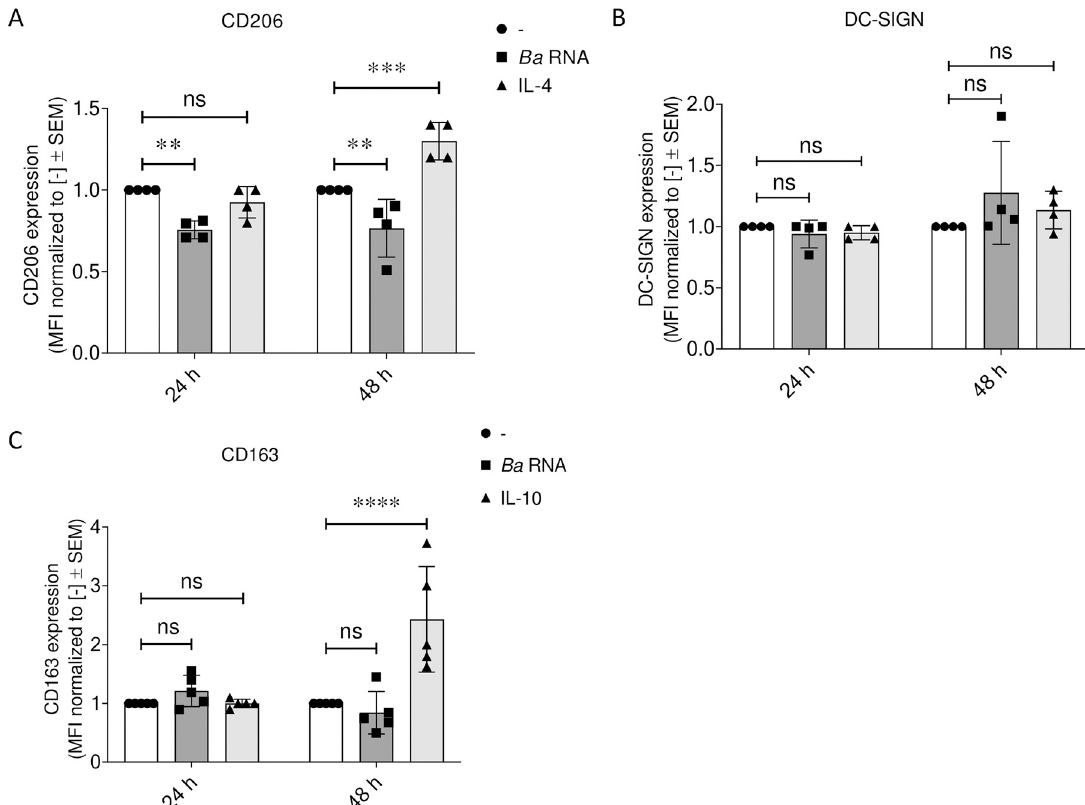
Fig 3. Ba RNA does not modulate the expression of M2 markers. Human M0 macrophages were stimulated with Ba RNA for 24 and 48 h. (A) CD206, (B) DC-SIGN and (C) CD163 (M2 markers) expressions were determined by flow cytometry. Cells treated with IL-10 or IL-4 were used as controls. Bars indicate the geometric means normalized to untreated cells ± SEM of at least four independent experiments. MFI, mean fluorescence intensity. ns, non-significant; �� P < 0.01; ��� P < 0.001; ���� P < 0.0001 vs. untreated cells